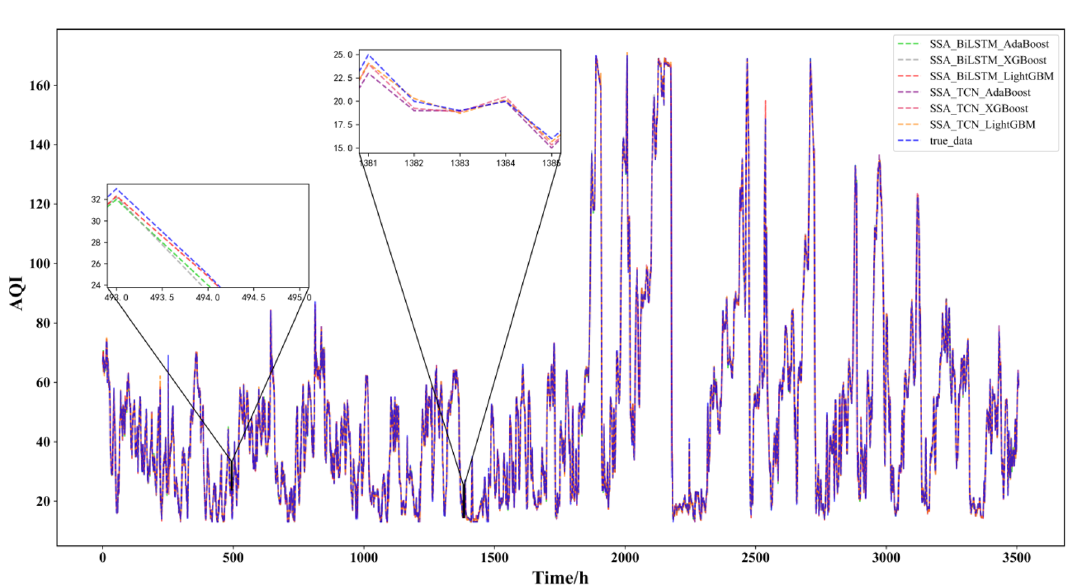
Figure 11. Prediction experimental results of combination models based on